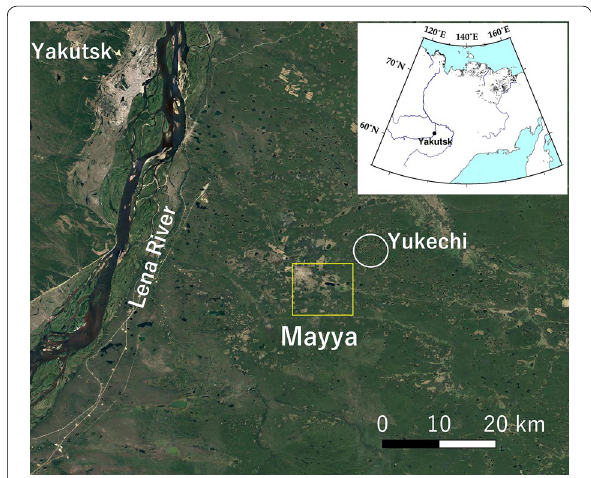
Fig. 1 Study area. Google Earth image of the right bank of the Lena River, near Yakutsk. Yellow rectangle shows area enlarged in Fig.